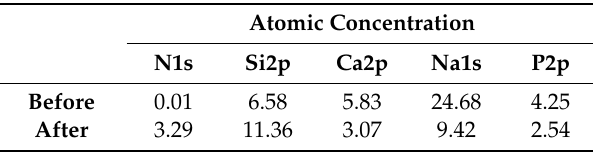
Table 1. X-Ray Photoelectron Spectroscopy (XPS) analysis showing the atomic concentration for each element present on the surface before and after the functionalization process.